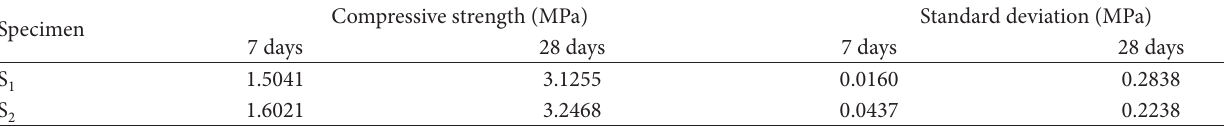
T 2: Compressive strength results for hardened specimens.